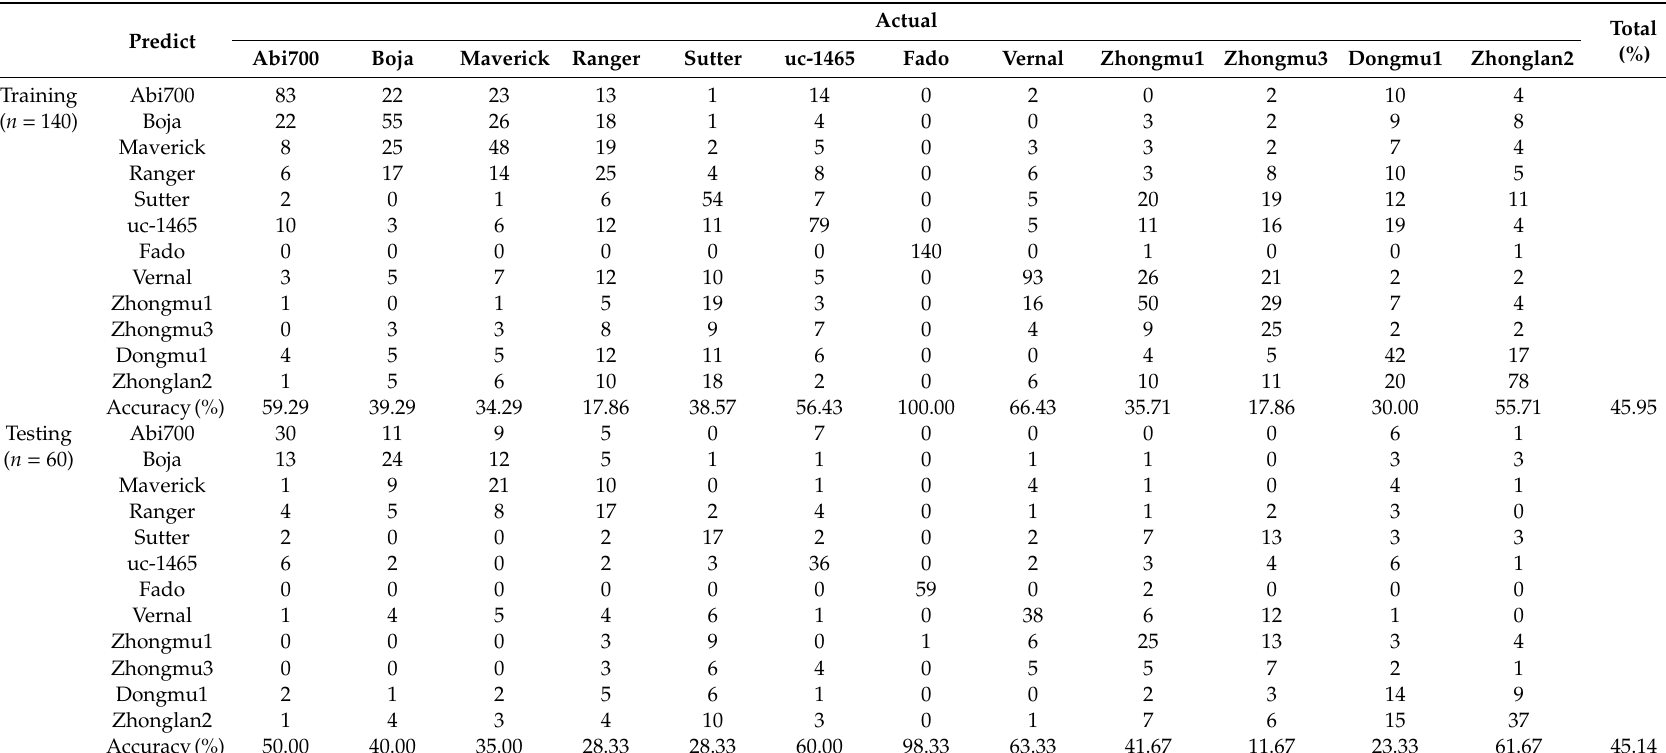
Table 2. Discrimination performance based on SVM with morphology features of 12 Medicago sativa L.